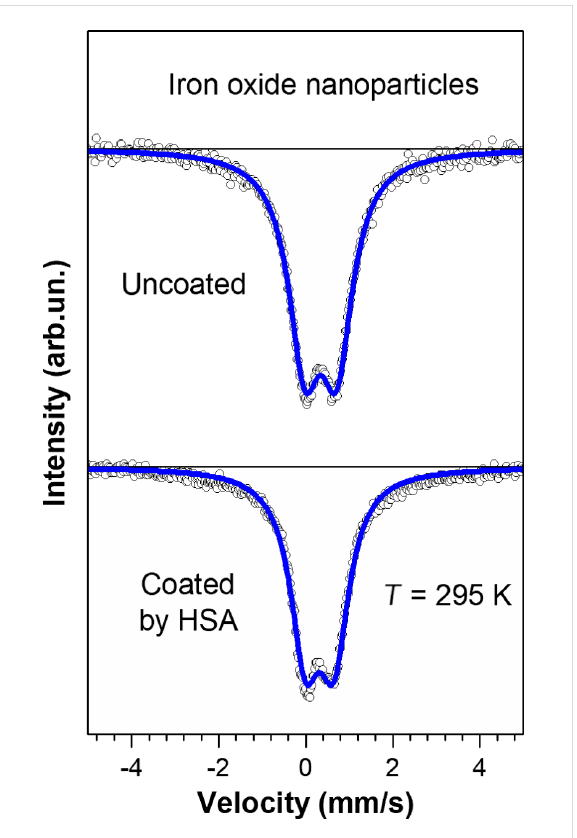
Figure 5: Room temperature Mössbauer spectra of HSA-coated mag- netic nanoparticles and uncoated particles. The solid lines are a fit to the experimental